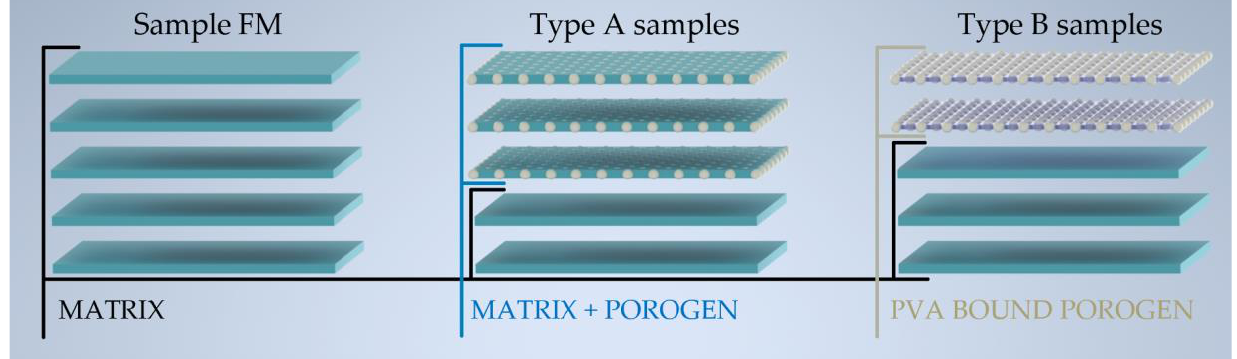
Figure 1. Graphical representation of layer composition in different sample types.